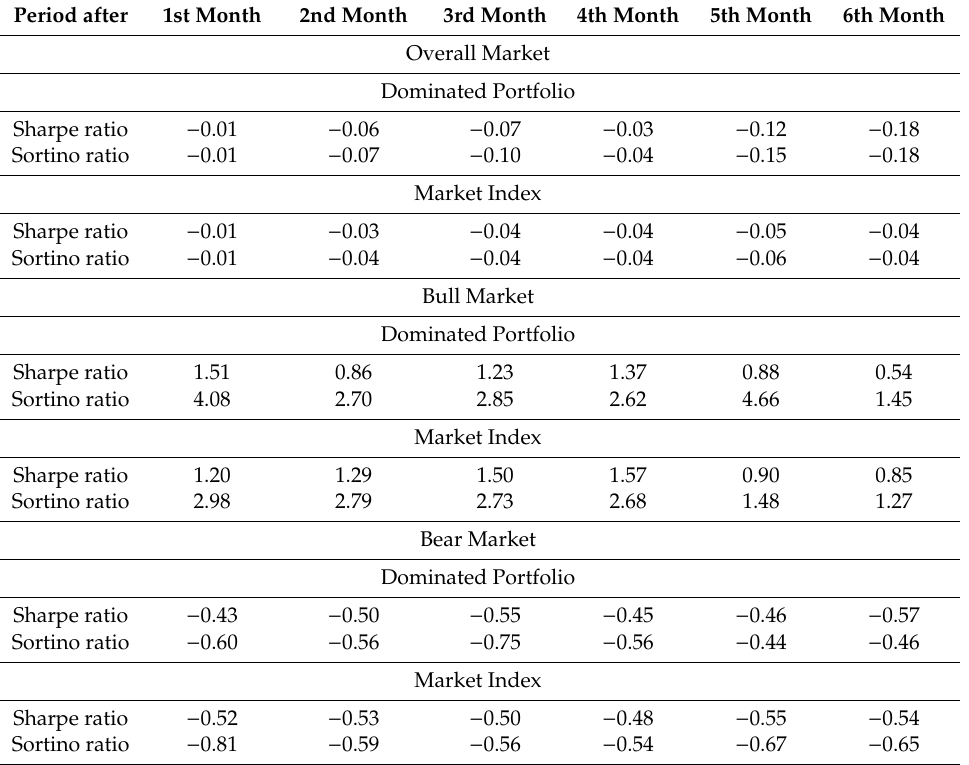
Table 3. The statistics of Sharpe and Sortino ratios for a dominated